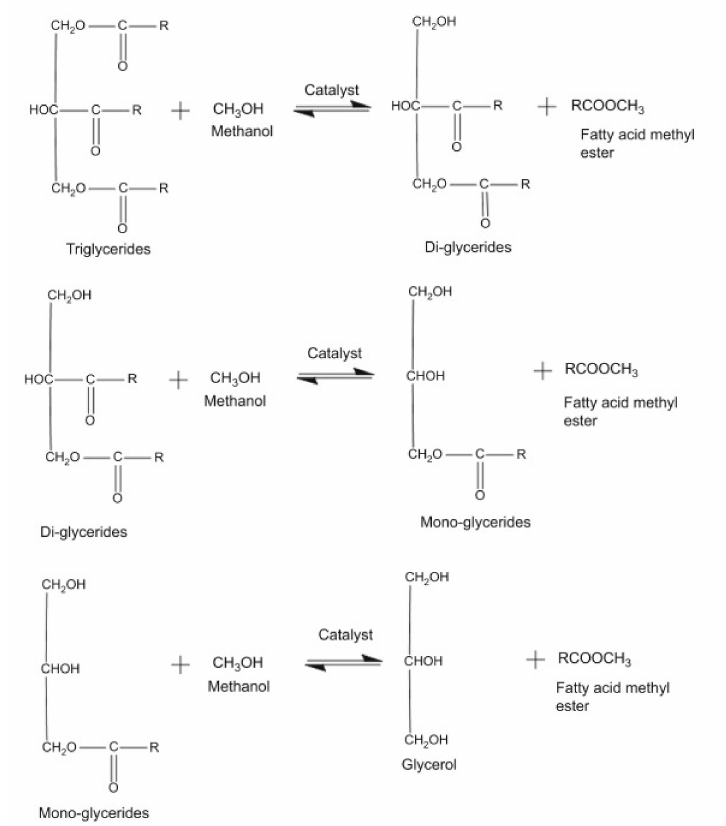
Figure 2. Mechanisms of transesterification. Adapted with permission from ref. [13]. 2019